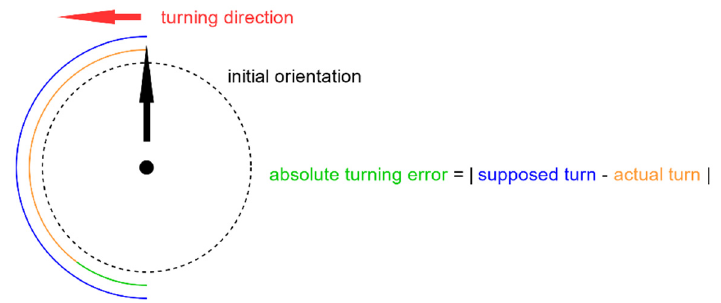
Figure 4. During the angular rotation task, the participant stood in a random direction. Via the Compass Experiment application, the participant was told in which direction and how far to turn from his initial position—either 90 ◦ , 180 ◦ or 360 ◦ . The absolute turning error was calculated by taking the absolute value of the difference between actual turning angle and the instructed turning angle.